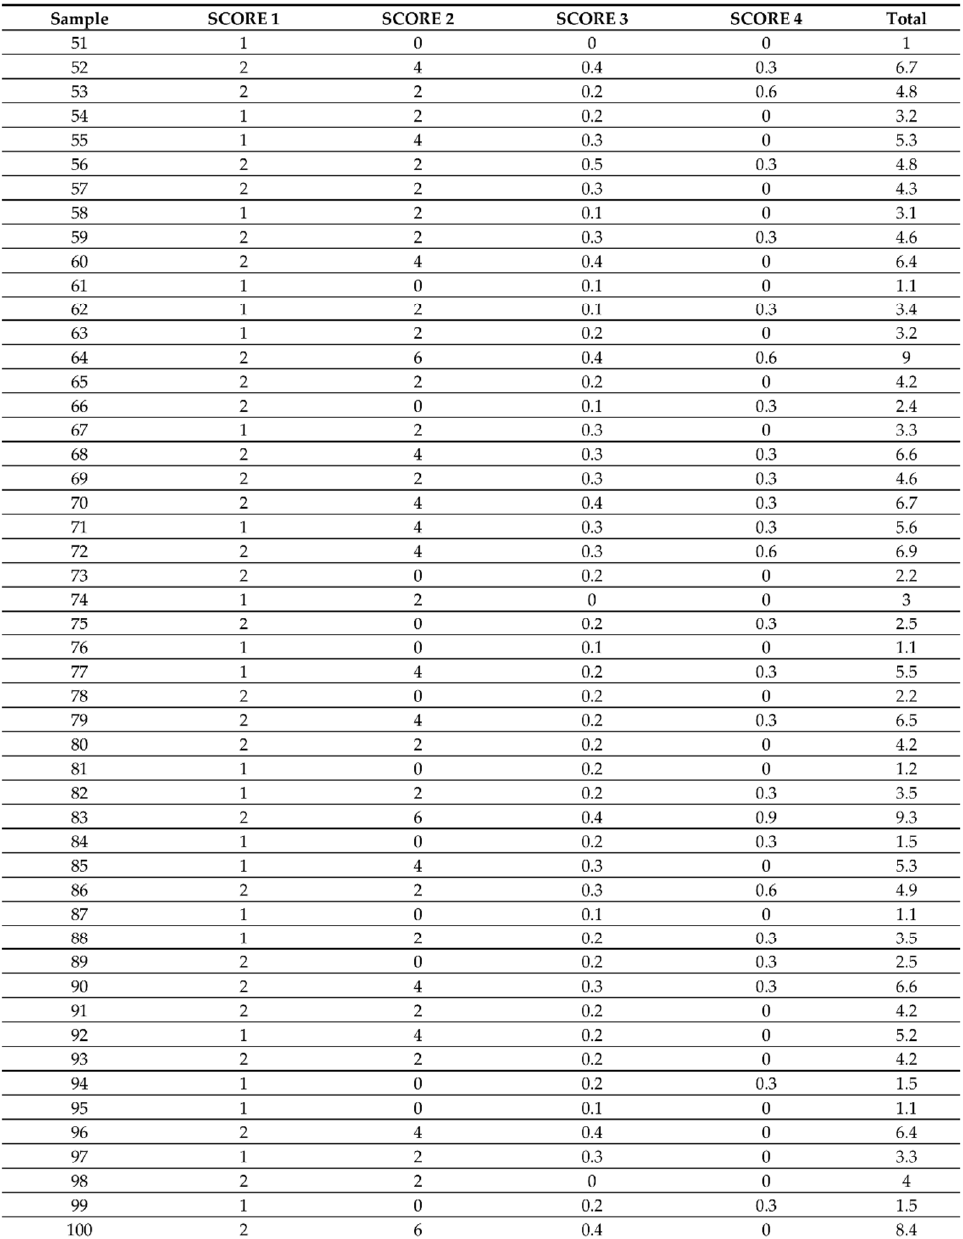
Figure A4. Space Time Permutation Scan Statistic results summary (last 50 samples).